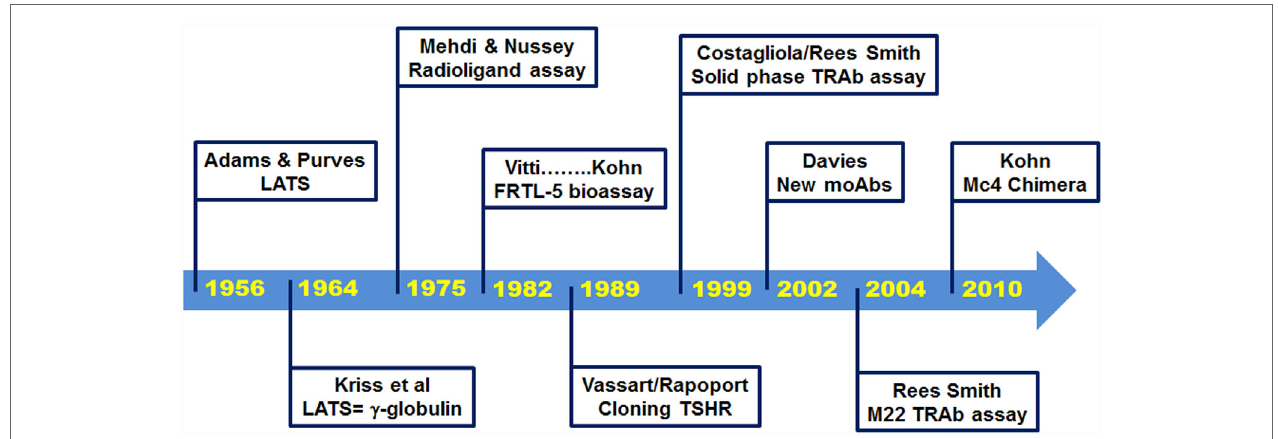
FiGURe 1 | Milestones in history of TSH receptor antibody assays